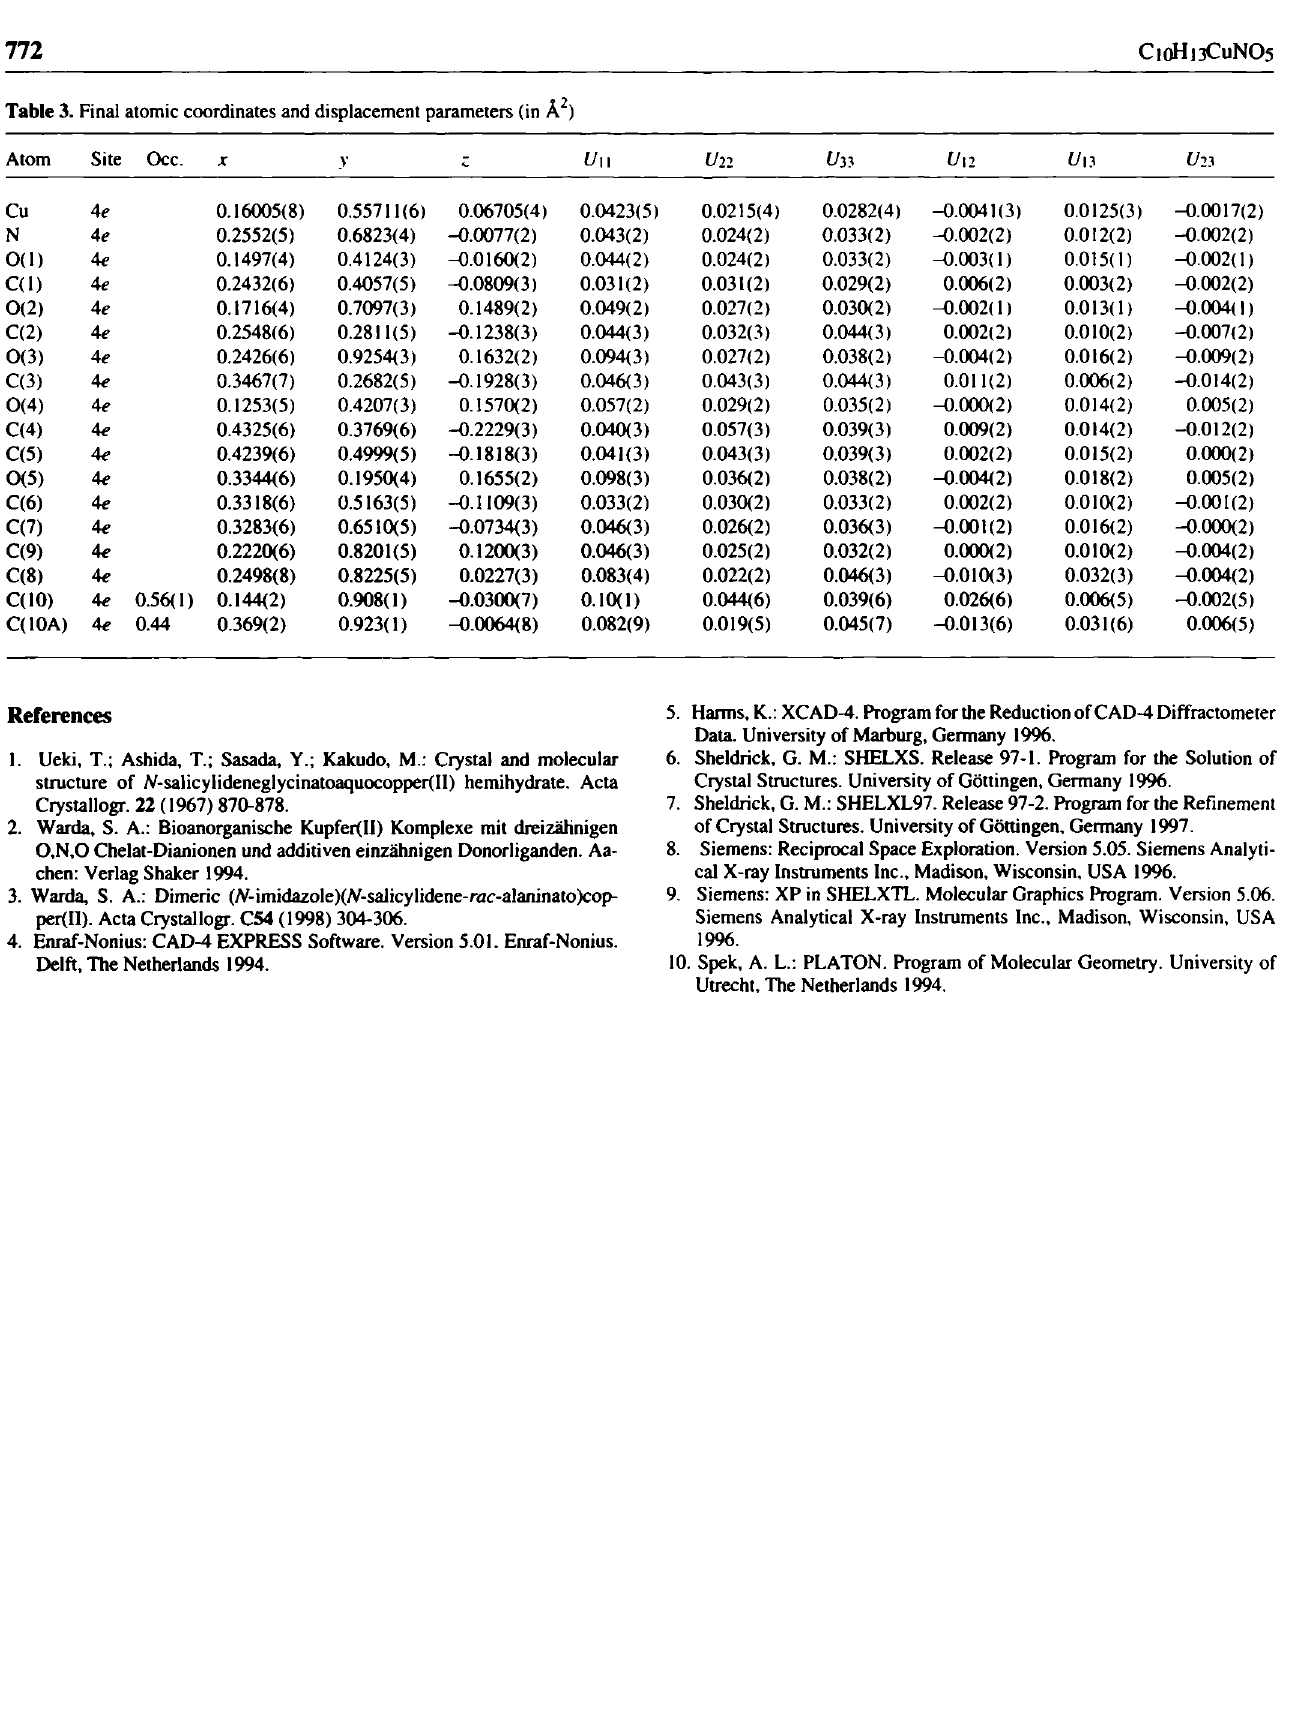
Table 3. Final atomic coordinates and displacement parameters (in Â^) Atom Site